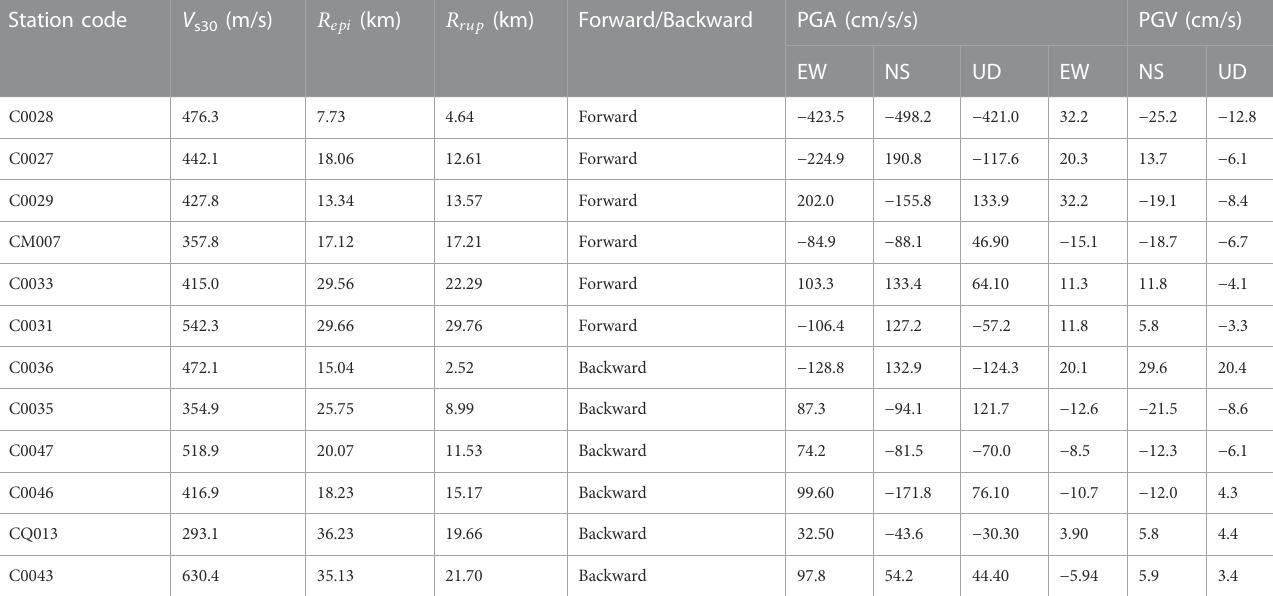
TABLE 1 Ground motion parameters of strong motion recording for stations within 30 km observed in the M S 6.9 Menyuan earthquake. Station code